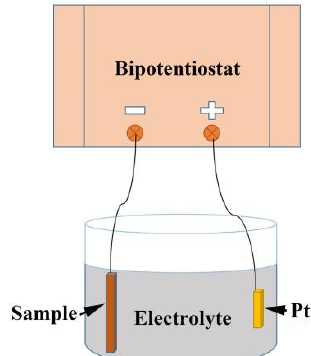
Figure 1. Schematic diagram of electrochemical hydrogen charging set-up.